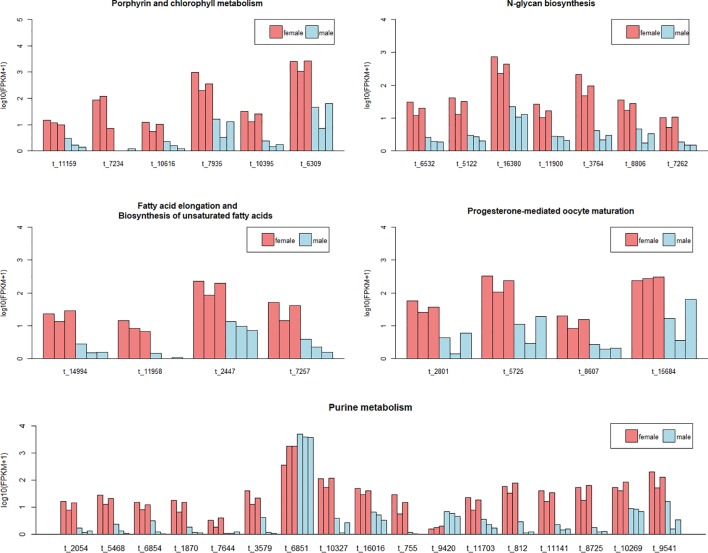
The expression level of the differentially expressed transcripts (DETs) of muscle in five pathways. Each bar represents one sample. Different colors indicate different sexes. The abscissa represents the transcript ID. The ordinate represents the logarithm of the (FPKM+1). Since the DETs in pathways of fatty acid elongation and biosynthesis of unsaturated fatty acids were same, we combined the two pathways in one plot.